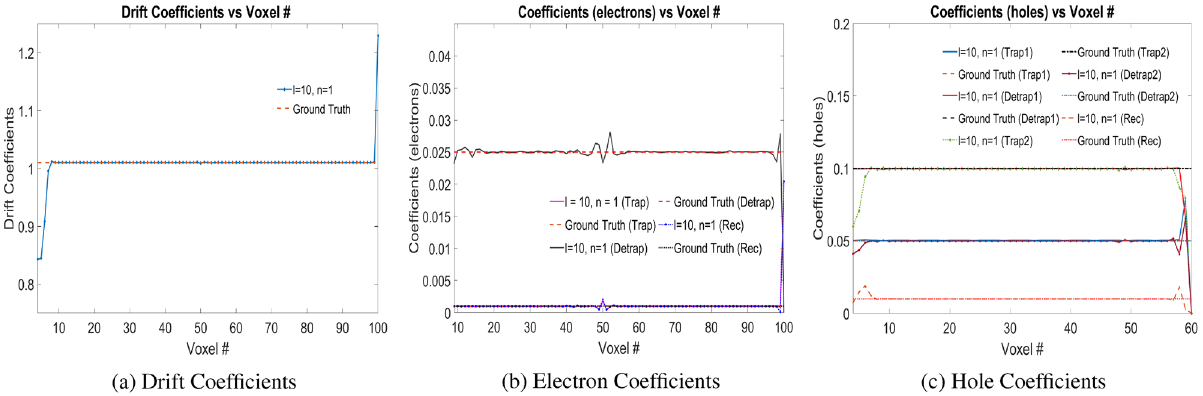
Figure 6. ( a ) Drift coefficients ( µ e ), ( b ) electron coefficients ( w eT , w eD , w eRec ), and, ( c ) hole coefficients ( w hT ,1 , w hD ,1 , w hT ,2 , w hD ,2 , w hRec ) for e–h injection at voxel positions 9 with stride of 5 voxels until voxel 59 for l and n in Physical Model-2 as shown in the plot legend. Rec in the legend refers to recombination coefficients. Readers are suggested to enlarge the figure for closer view.